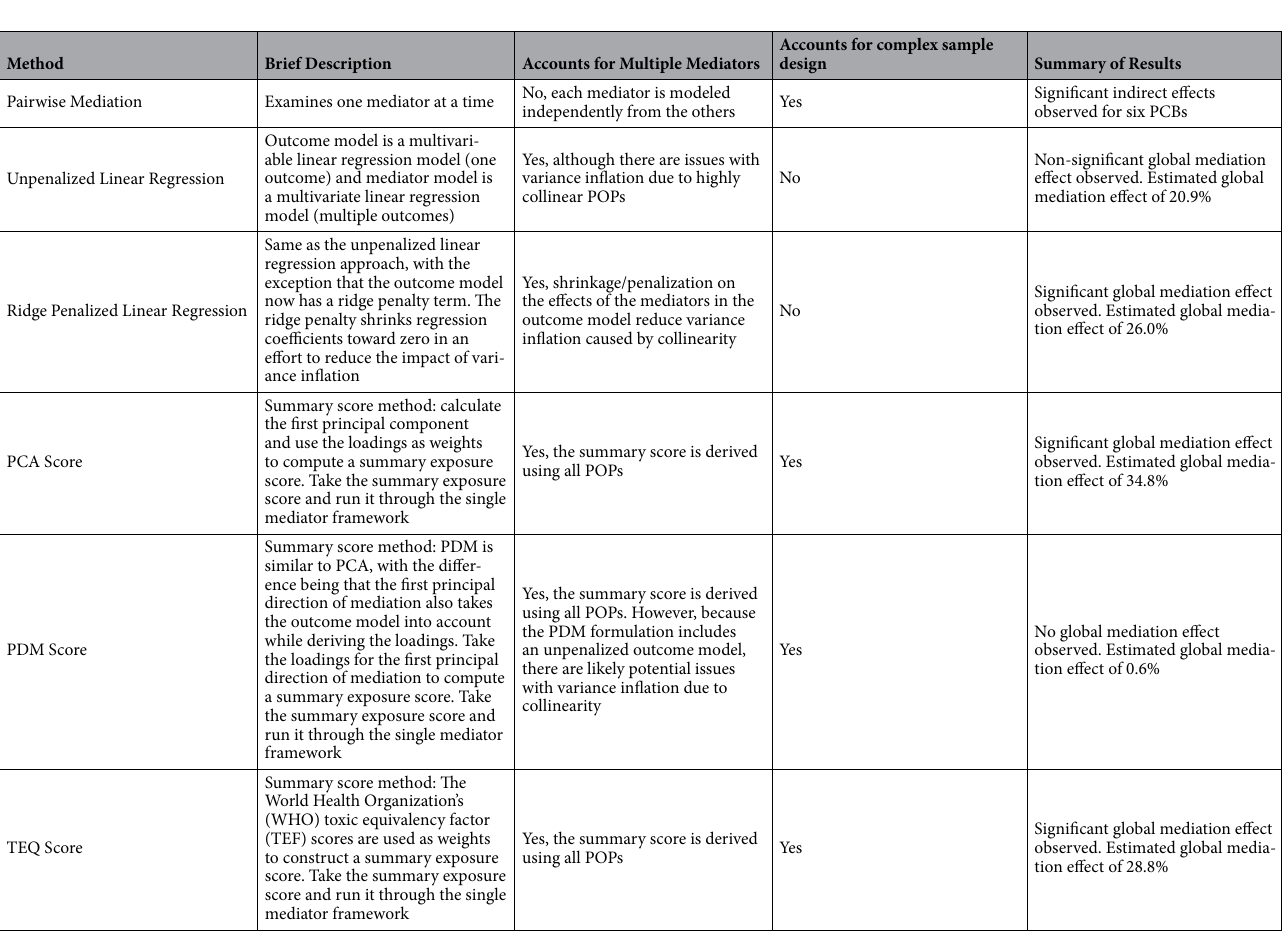
Table 2. Overview of analytical mediation models and methods considered in this